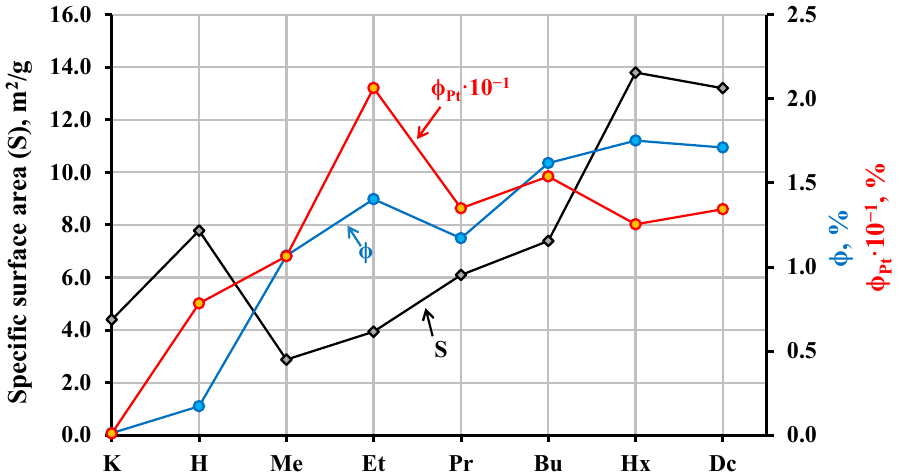
Figure 9. Correlation between apparent quantum efficiency ϕ and specific surface area (Kr) of the samples.